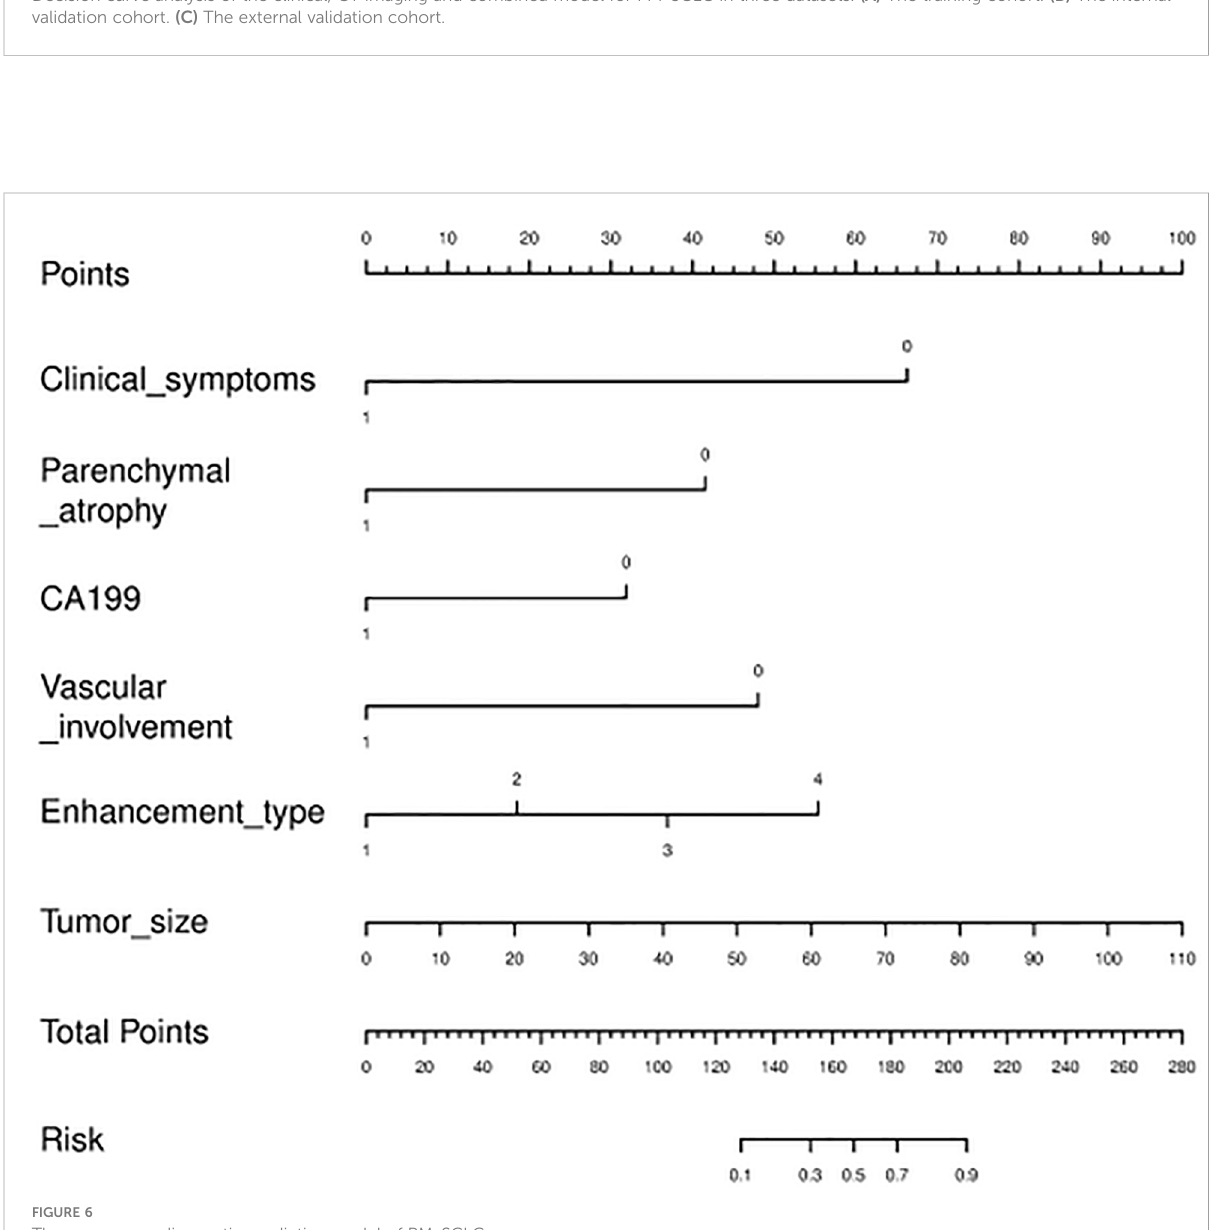
FIGURE 6 The nomogram diagnostic predictive model of